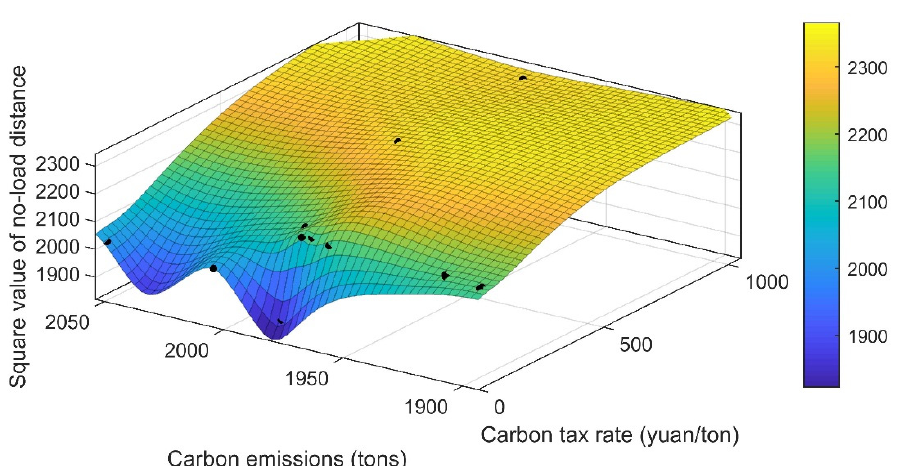
Figure 5. Carbon emissions and changes in square values of no-load distance under the influence of a carbon tax price.